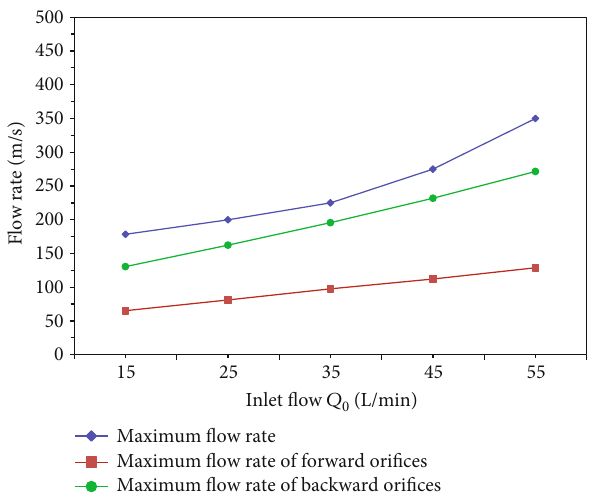
Figure 7: Comparison of the maximum speed of the injector under di ff erent inlet displacements.